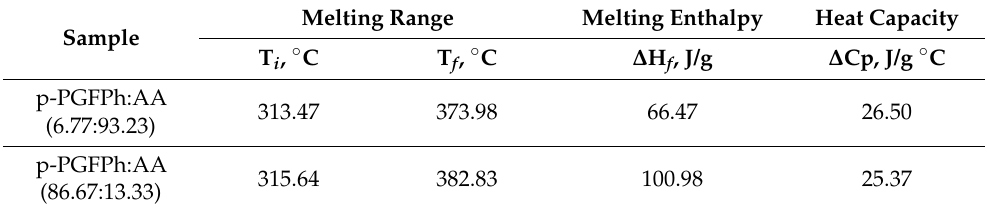
Table 1. p-PGFPh:AA copolymers heat capacity at different ratios, at heating rate 10 ◦ C/min. Melting Sample